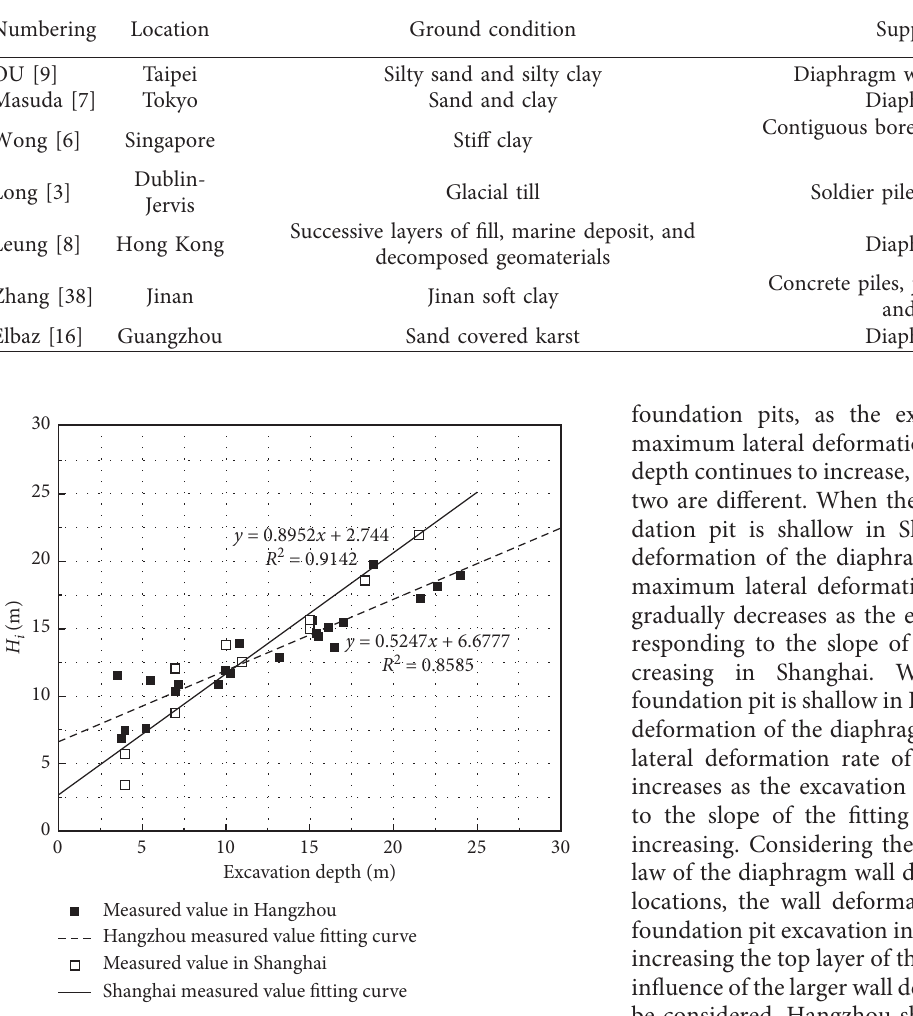
Figure 7: The relationship between the excavation depth and the corresponding position of the maximum lateral deformation within the excavation